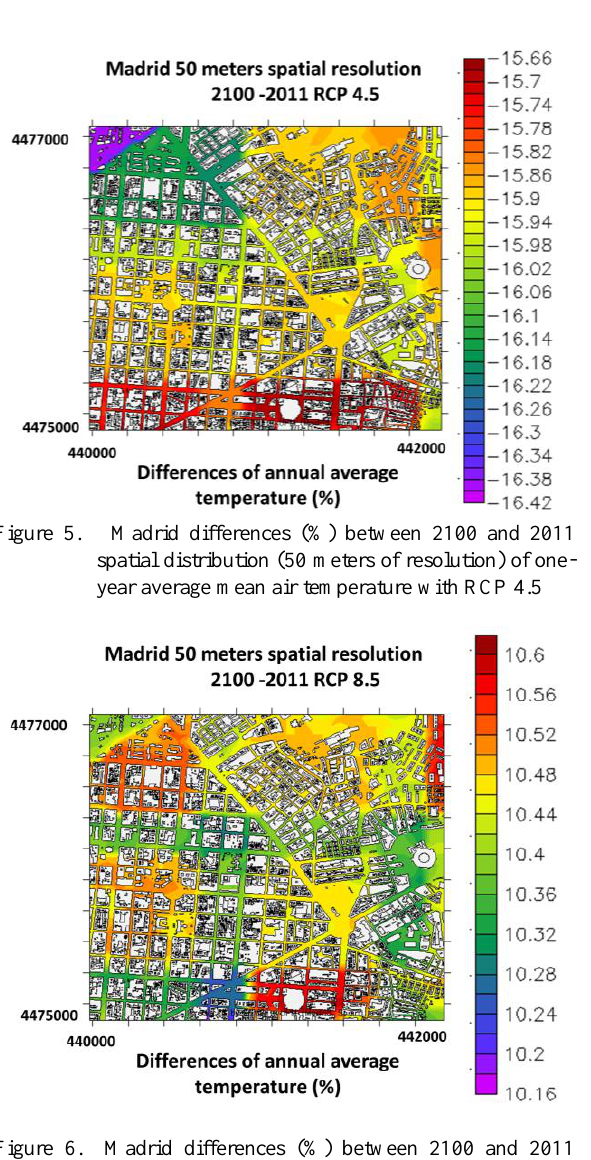
Figure 6. Madrid differences (%) between 2100 and 2011 spatial distribution (50 meters of resolution) of one- year average mean air temperature with RCP 8.5.